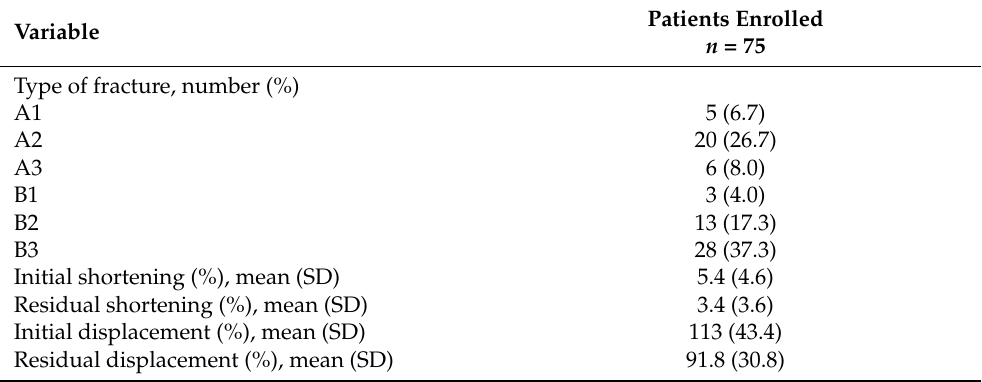
Table 2. Radiological characteristics of patients.